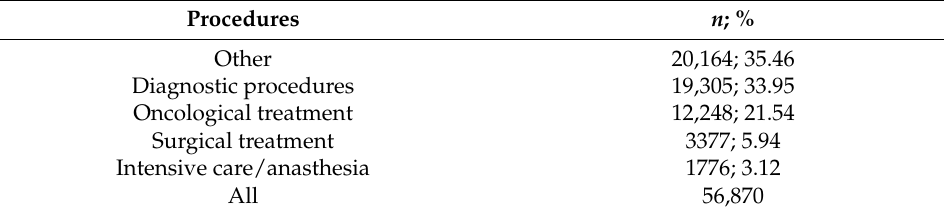
Table 5. Procedures during hospitalizations.